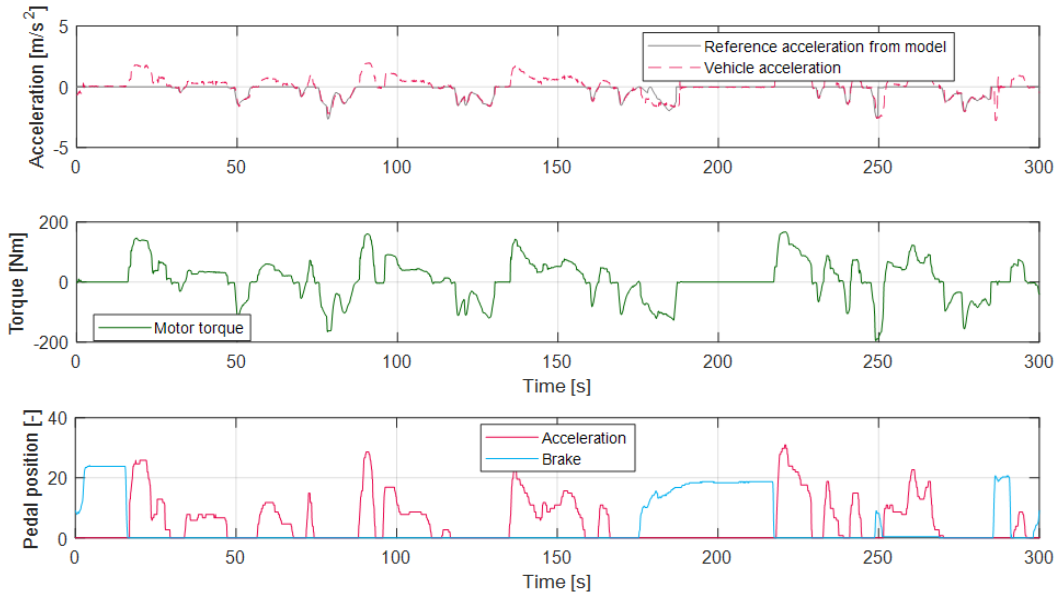
Figure 26. Deceleration prediction model-based regenerative control